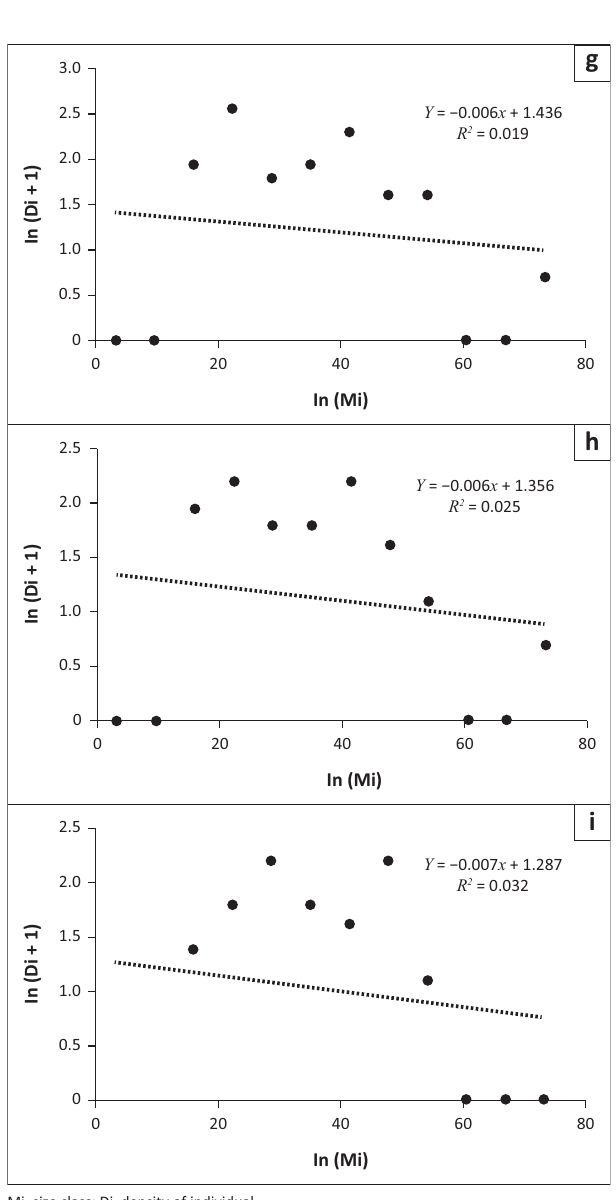
FIGURE 1-A1 (Continues...): Linear regressions fitted on the ln (Mi) against ln (Di + 1) of live trees at Grootkolk in the Kalahari Gemsbok National Park in (a) 1979, (b) 1984, (c) 1986, (d) 1989, (e) 1994, (f) 1996, (g) 1999, (h) 2008 and (i) 2016, where Mi, midpoint of the size class and Di, density of